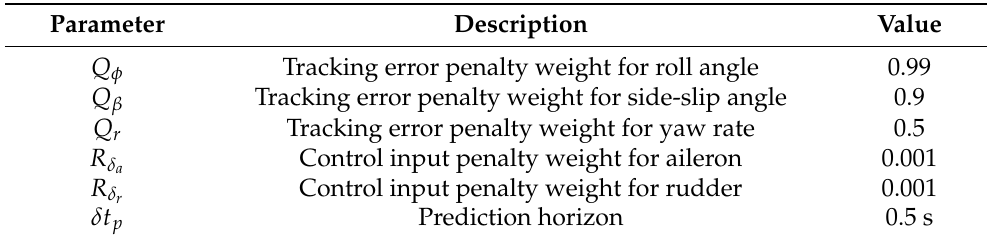
Table 3. Design parameters of AMPC for lateral control.